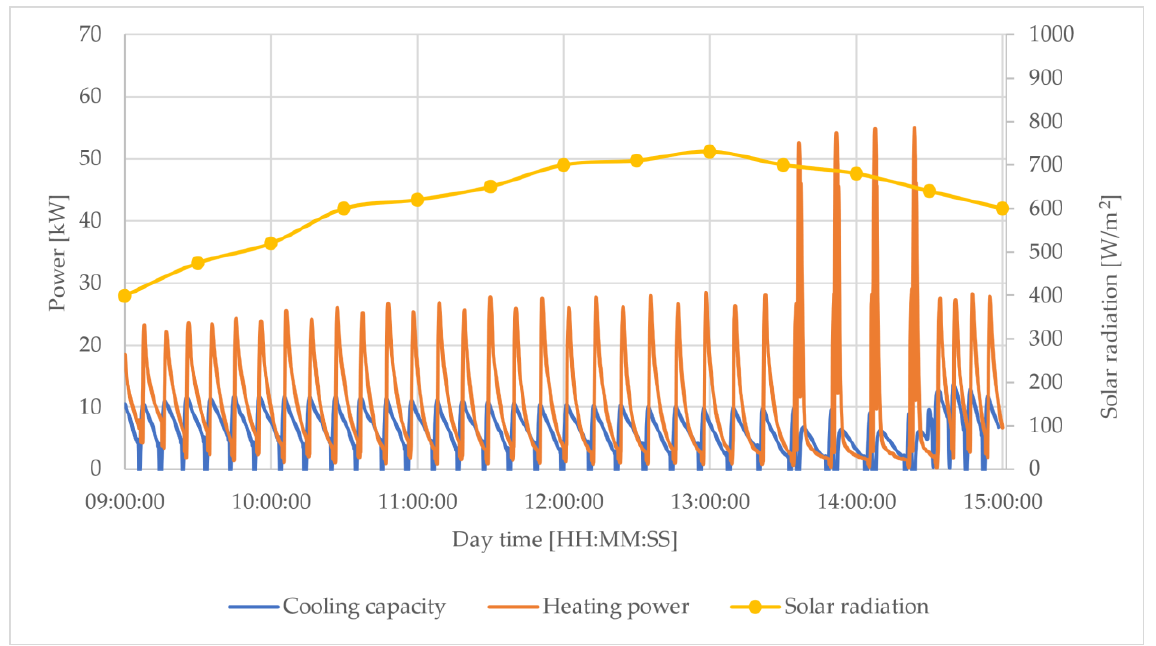
Figure 21. Measured values of temperatures and flow rates over time for 21st August.